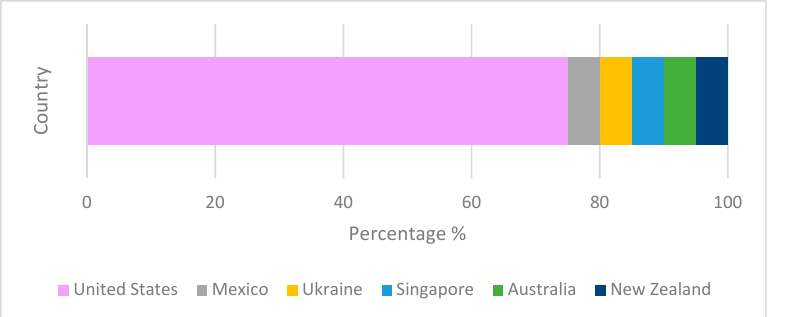
Figure 3. Patents for DM with A61K36/00 IPC classification that were published between 2016 and 2022. (100% represents the total number of 19 patents).